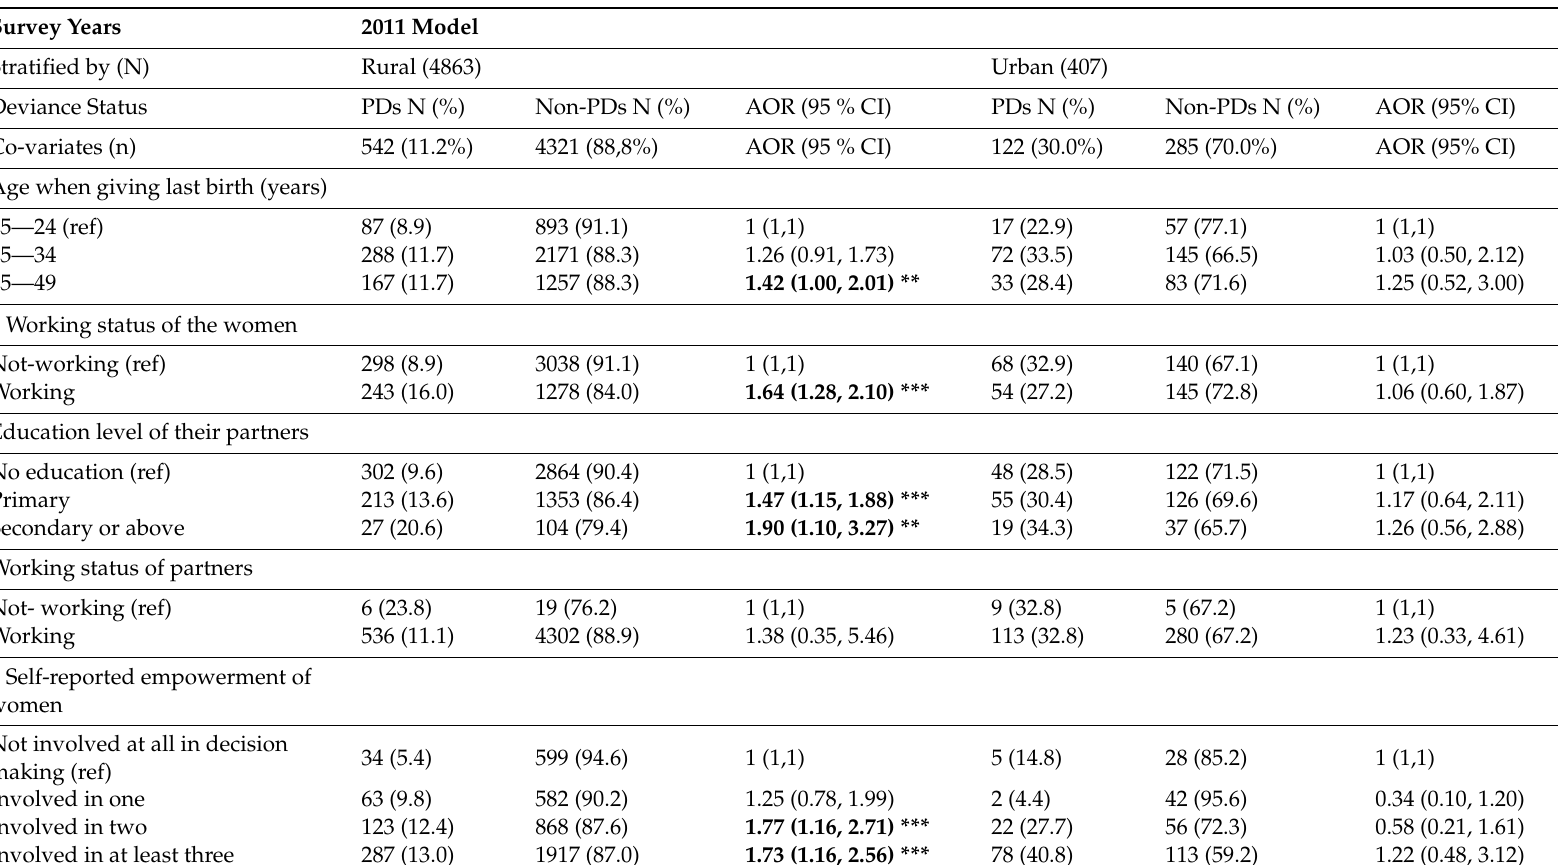
Table 2. Results of multiple multilevel logistic regression exploring factors associated with being a positive deviant for antenatal care utilization among urban and rural women, 2011 Ethiopia